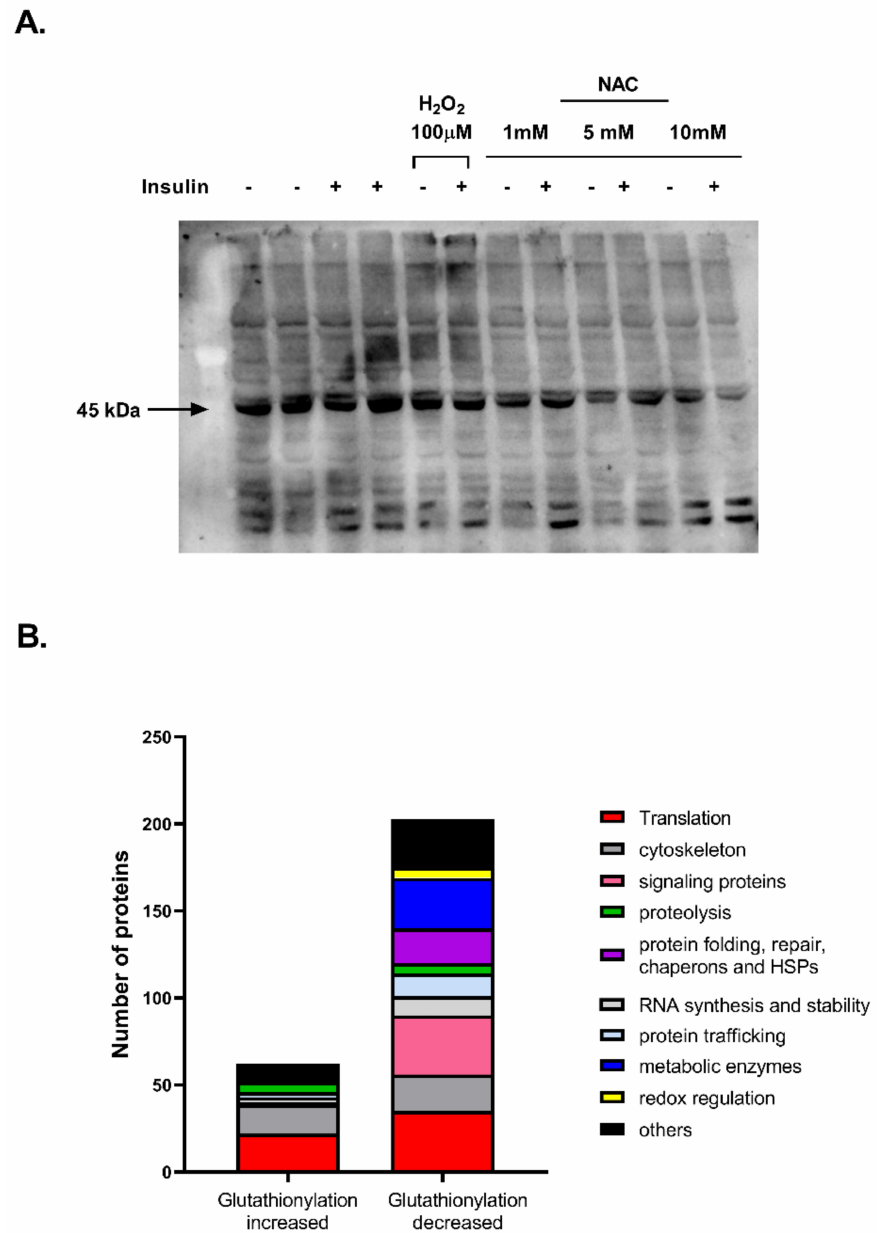
Figure 8. Protein glutathionylation is reduced by NAC in L6 cells. L6 myotubes were treated with H 2 O 2 or NAC for 24 h. ( A ) Western blot analysis was performed under non-reducing conditions using anti-GSH antibody. Representative blot of 3 independent experiments is shown. ( B ) Number and classification of proteins with glutathionylation level that was increased or decreased by NAC. Level of glutathionylation was detected in L6 myotubes by mass spectrometry as described in Methods. Function of affected proteins was determined using